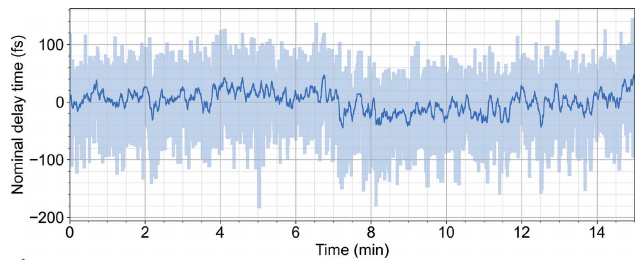
Figure 12 Plot of temporal jitter measured over 15 min. The darker blue line shows the rolling mean over 5 s (Sato et al. ,